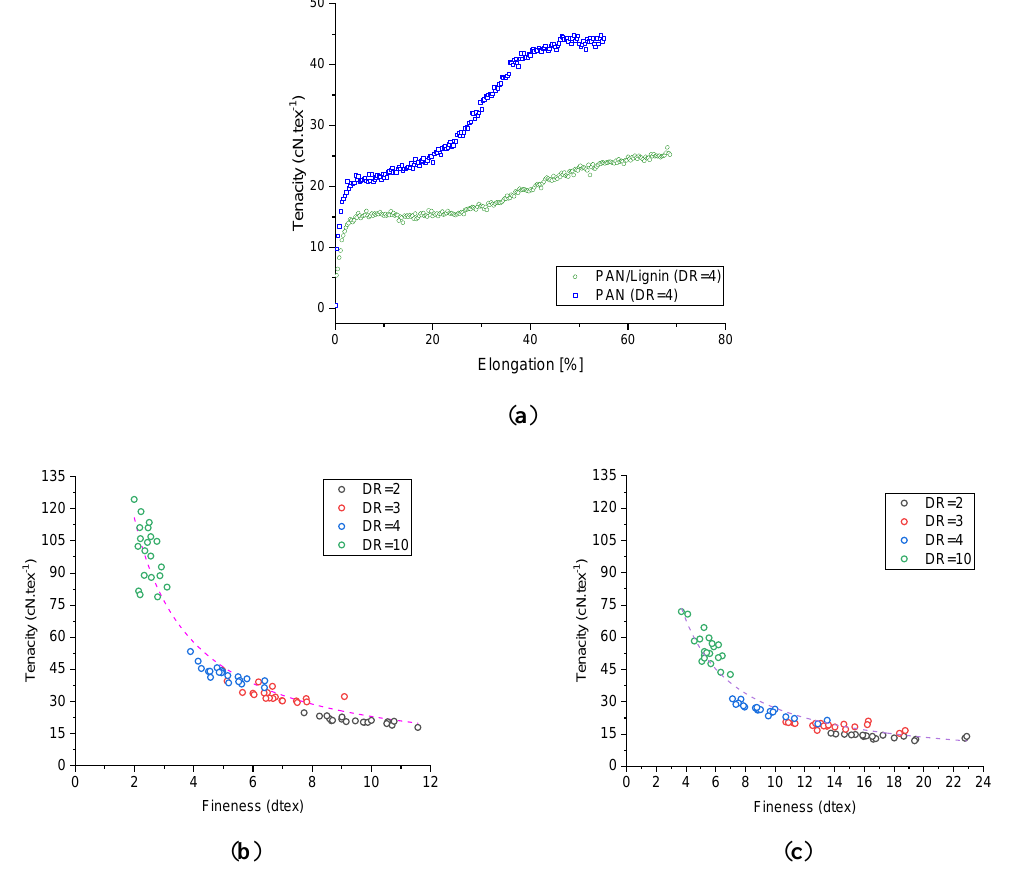
Figure 6. ( a ) Tenacity–elongation curves of PAN and PAN/lignin fibers (draw ratio (DR) = 4; spinning temperature 85 °C; coagulation bath temperature 6 °C; pump rotational speed 0.5 rpm; and V1= 10 m·min −1 ); tenacity–fineness curves of ( b ) PAN-series and ( c ) PAN/lignin-series at different draw ratios.